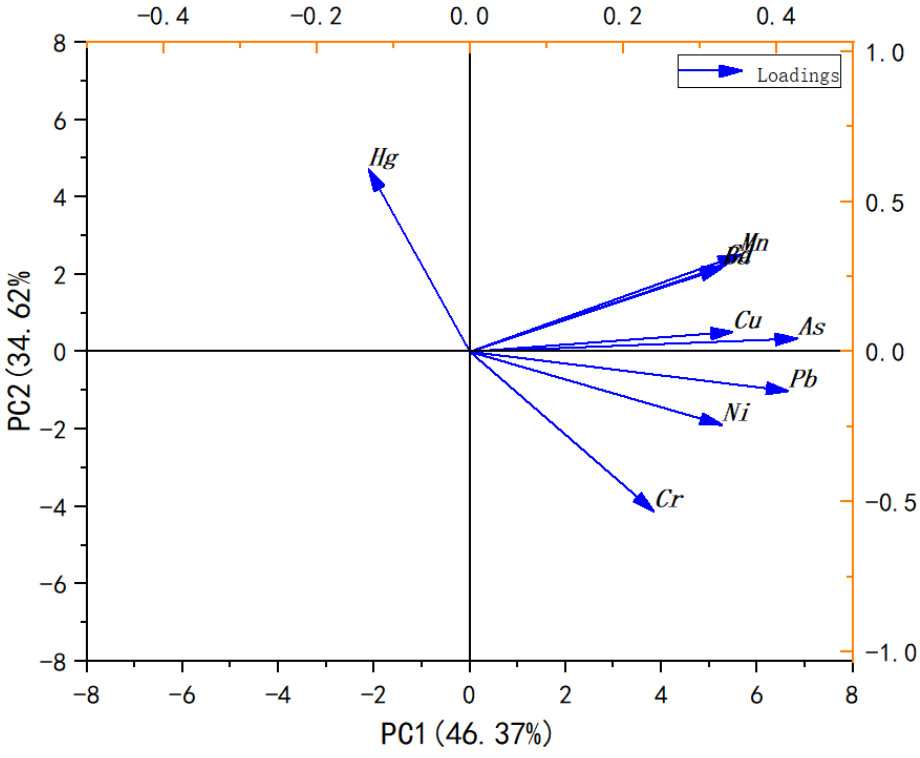
Figure 5. Loading plot of rotated PCA analysis of nine metals in the crayfish samples.